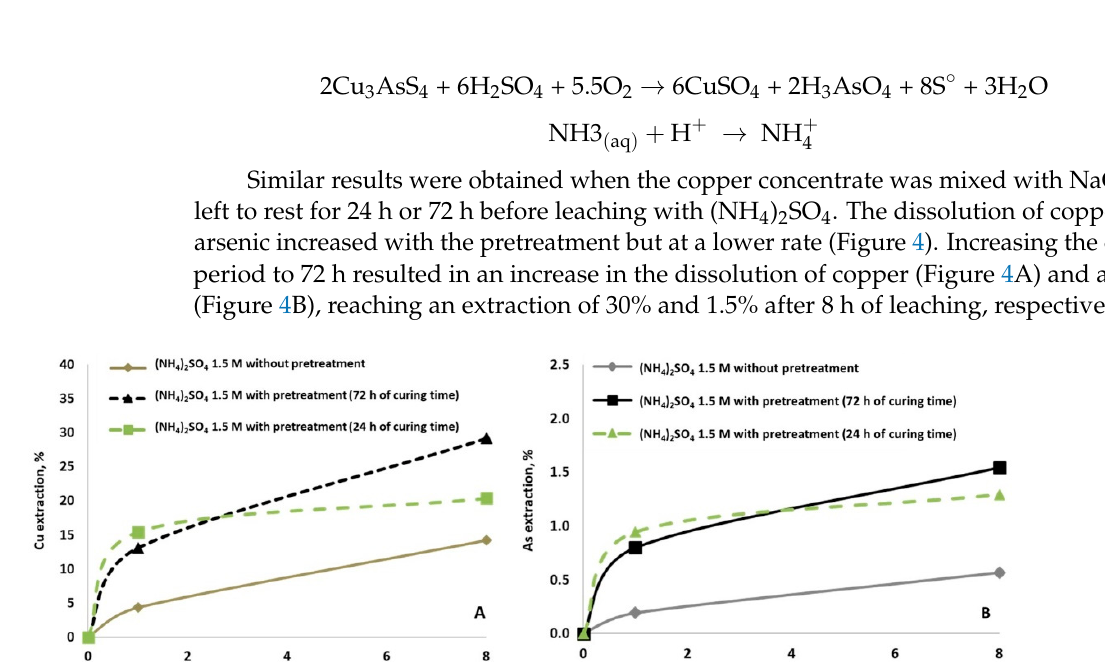
Figure 3. Copper ( A ) and arsenic ( B ) extraction at ambition condition using 1.5 M of NH 4 Cl without and with pretreatment (15 g/L of NaCl and curing time of 24 h and 72 h).